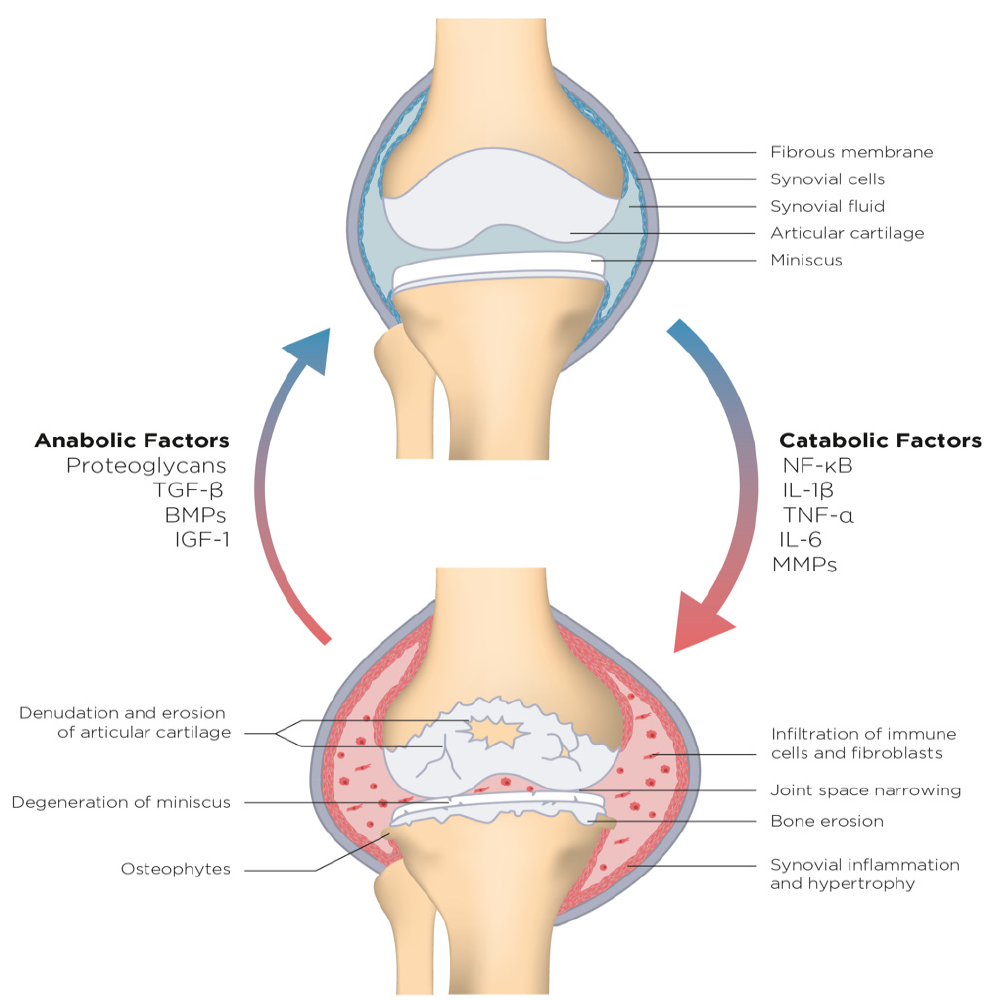
Figure 1. In osteoarthritic joints, a stimulated increase in the production of proinflammatory cytokines causes an overactivity of catabolic factors that provoke degenerative changes to all articular tissues. In response, anabolic pathways set out in vain to increase matrix production and repair the tissue damage. Exaggerated responses may lead to hypertrophy of chondrocytes and osteophyte formation. Another significant process contributing to pain and disability in osteoarthritis